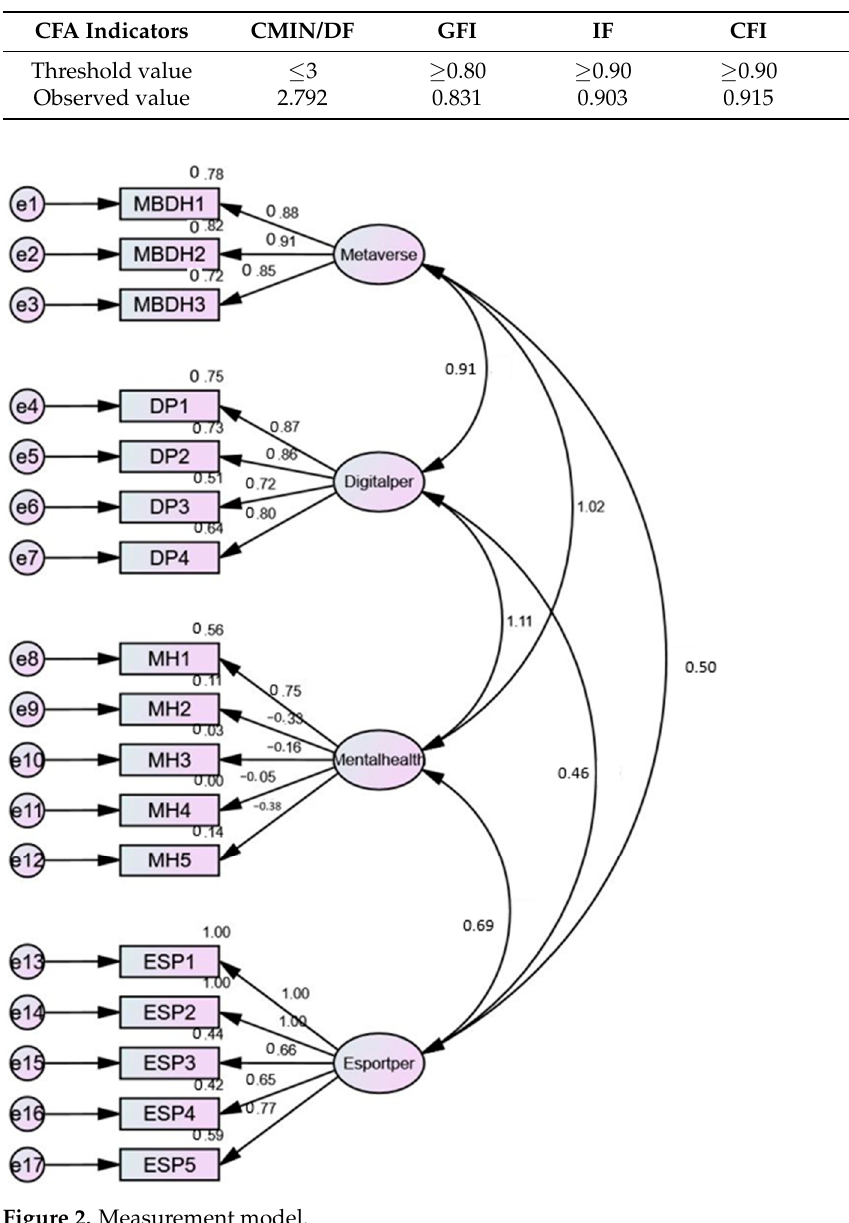
Table 6. Model fit indices.